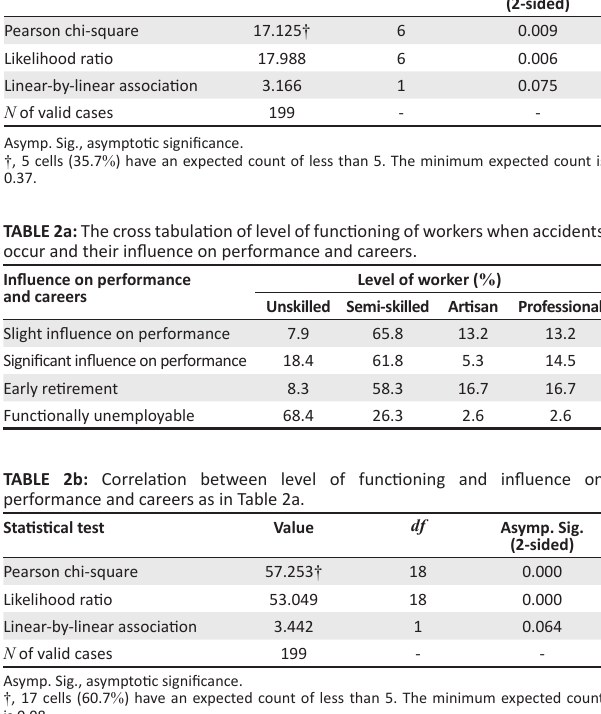
TABLE 1b: Correlations between age and influence on careers as in Table 1a. Statistical test